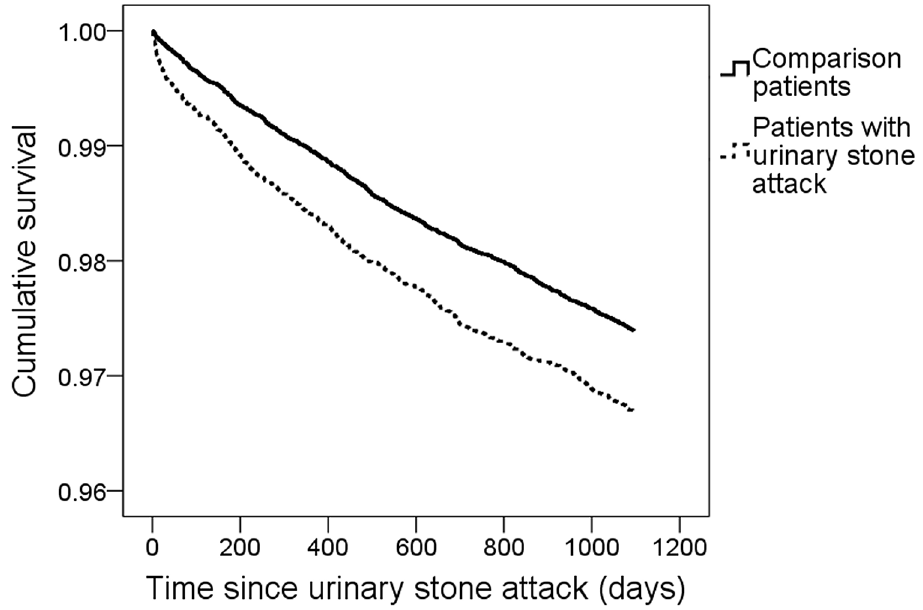
Fig 1. Time-related factors associated with new-onset irritable bowel syndrome occurrence. Irritable bowel syndrome-free survival curves for patients with urinary stone attack and comparison patients during the 3-year follow-up period ( p =